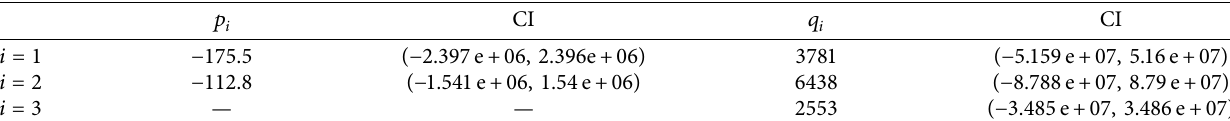
Table 13: HoF vs. Re G